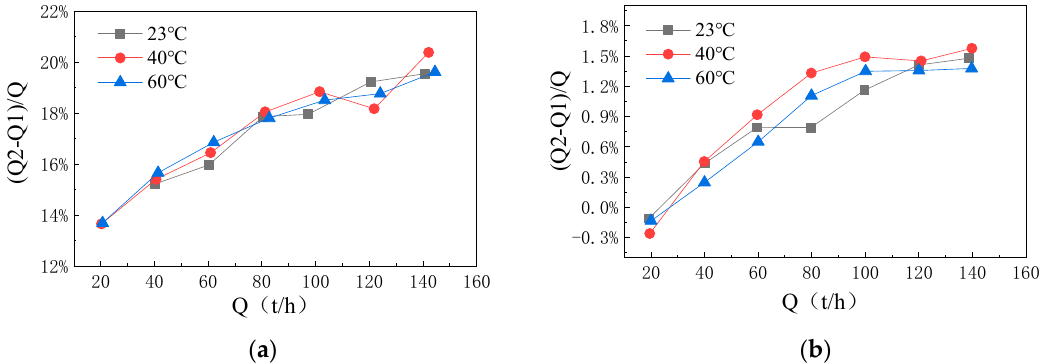
Figure 9. Variation of (Q2 − Q1)/Q vs. inlet flow rate at different temperatures. ( a ) no rectifier nozzle; ( b ) with rectifier nozzle. ( b ) with rectifier nozzle.